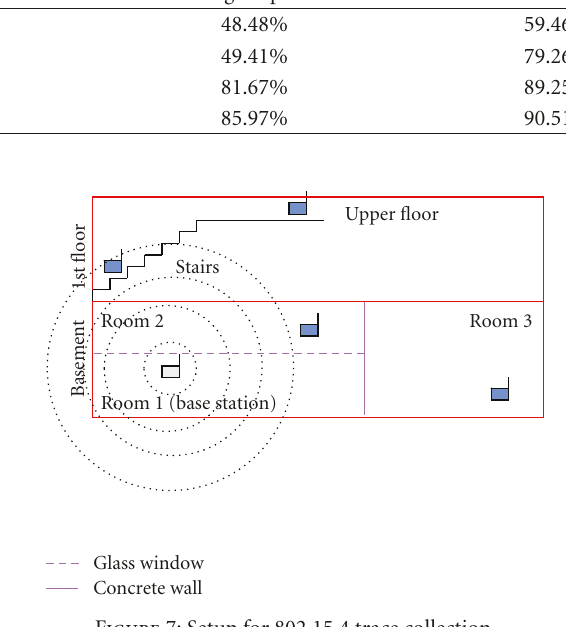
Figure 7: Setup for 802.15.4 trace